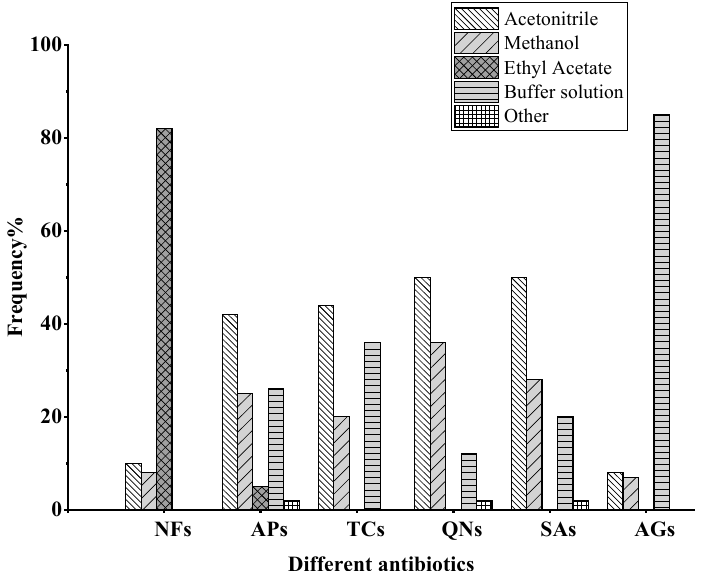
Figure 3. The proportion of different extraction solvents used for five kinds of antibiotics in articles from the recent decade.